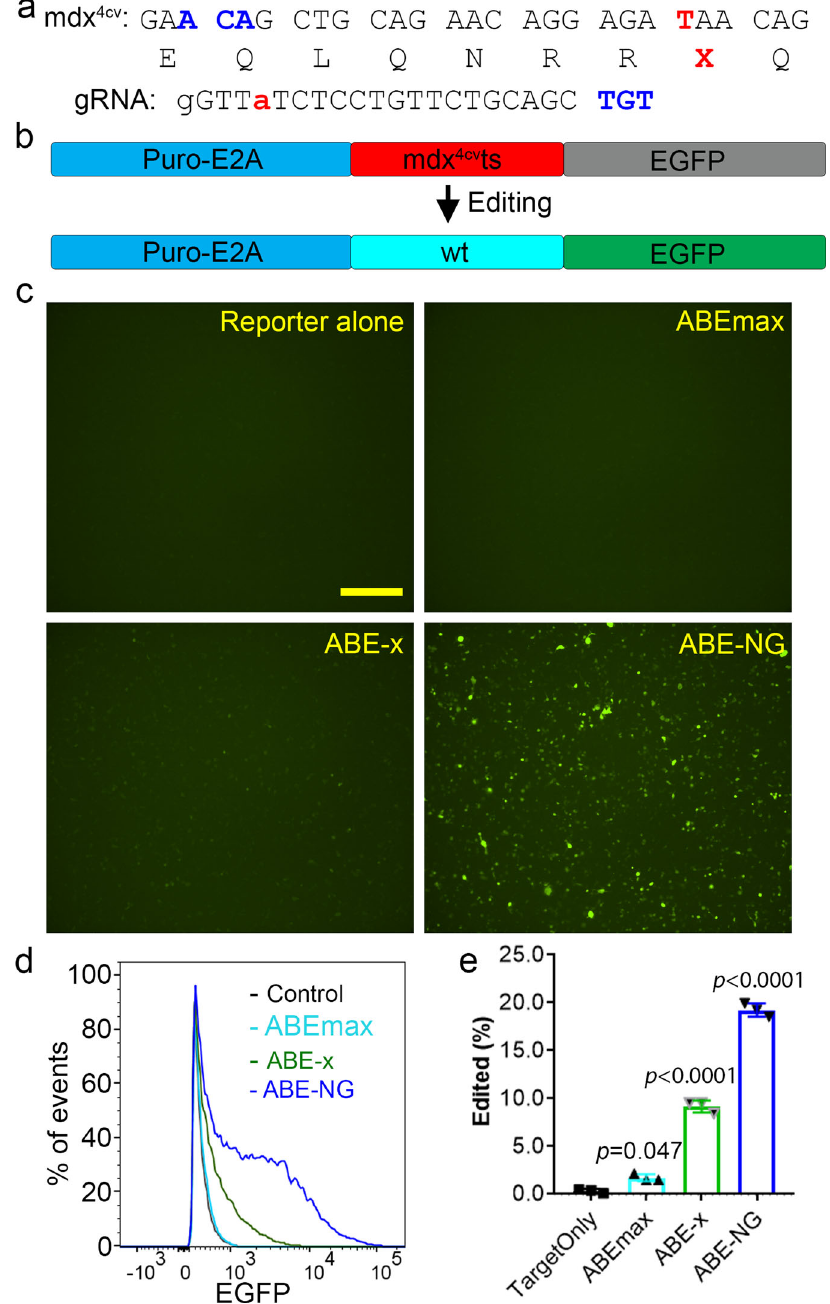
Fig. 1 In vitro studies of mdx 4cv mutation correction using ABE-NG. a Genomic DNA, encoded amino acids and guide RNA with PAM (highlighted in blue) sequences at the stop codon mutation site (red). b The reporter construct contains a puromycin resistance cassette fused with E2A peptide, mdx 4cv target sequence and ATG-removed EGFP. Correction of the stop codon within the target sequence would allow EGFP expression. c Fluorescence microscopy images of HEK293 cells transfected with reporter alone, or reporter, gRNA and one of the base editors (ABEmax, ABE-x, and ABE-NG). Scale bar: 500 µ m. d – e Flow cytometry analysis of EGFP expression in HEK293 cells transfected as described in ( c ). n = 3 wells/group; one-way ANOVA with Turkey ’ s multiple comparisons test. Data are mean ±